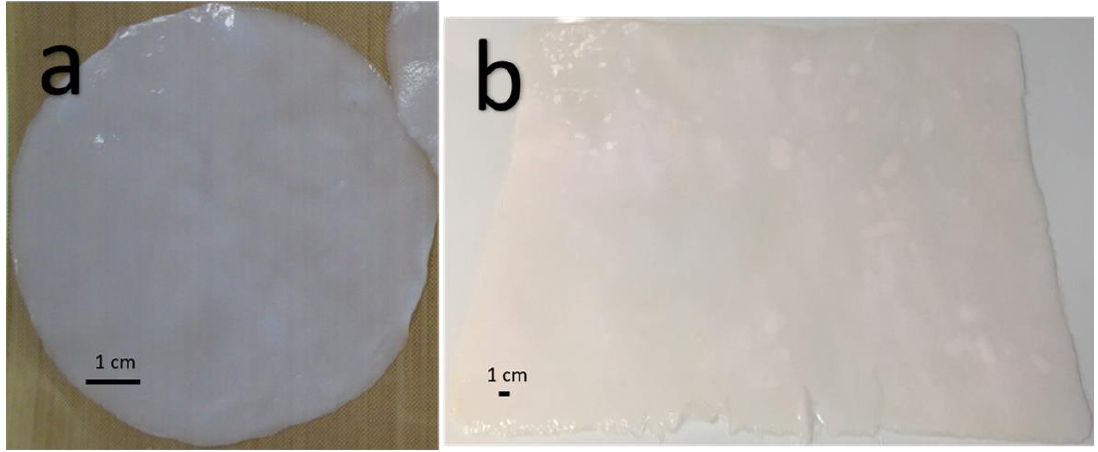
Figure 5. A comparative images of BNC membranes obtained in ( a ) small and ( b ) large scale in this research.